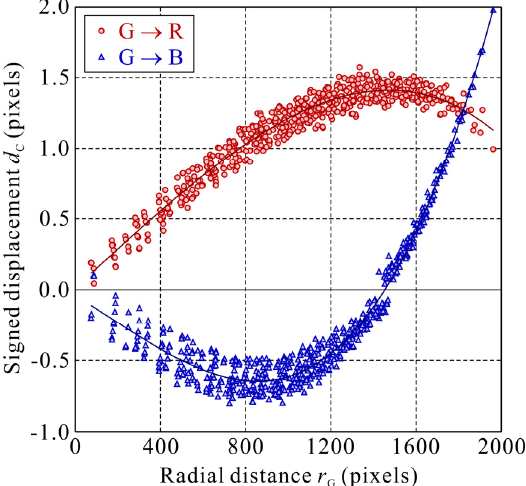
Figure 5. Signed displacements caused by chromatic aberration in the image shown in Figure 2